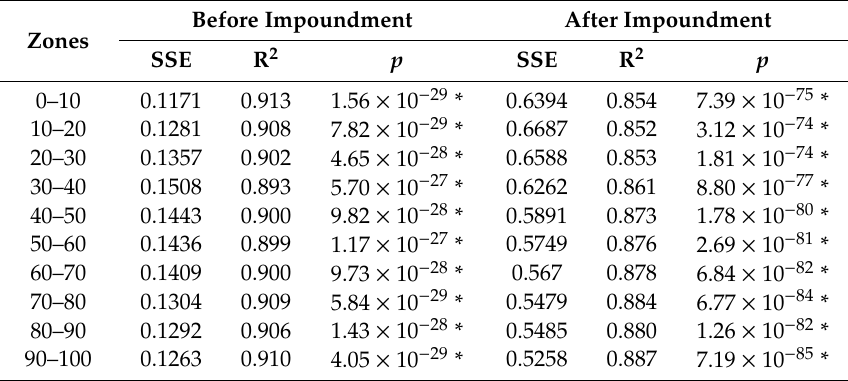
Table 3. Evaluation index of fitting